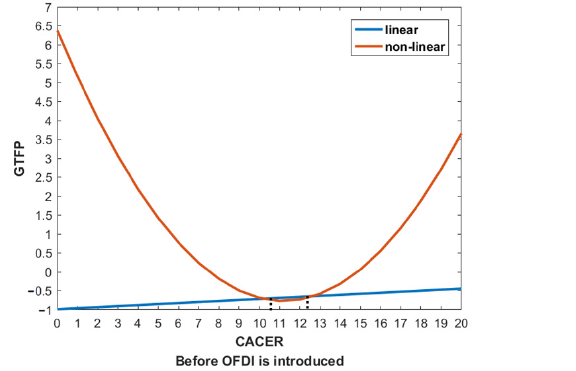
Table 9. Robust test